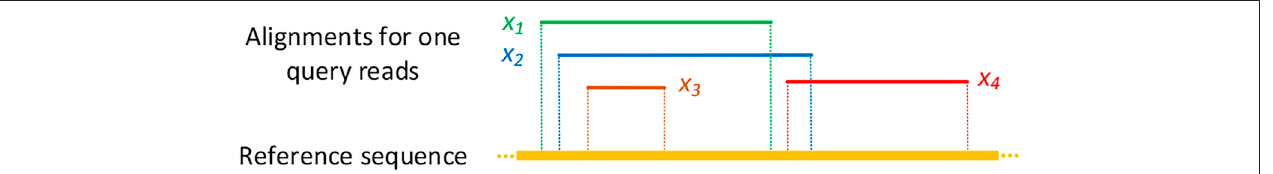
FIGURE 4 | Examples of covering and non-covering alignment results. x 1 , x 2 , x 3 , and x 4 are different alignment results reported by four mapping methods for the same query read. The dotted line indicates the mapped region in the reference genome sequence for the corresponding alignment result. In this fi gure, x 1 and x 2 alignmentscovereach otherastheyspanthemappedregionsonthereferencegenomethathaveatleast90%overlap. Thealignments x 1 and x 2 cover x 3 alignmentbut not the x 4 alignment, while x 3 does not cover x 1 and x 2 alignments. On the other hand, the alignment x 4 does not cover either alignment x 1 , x 2 , or x 3 .